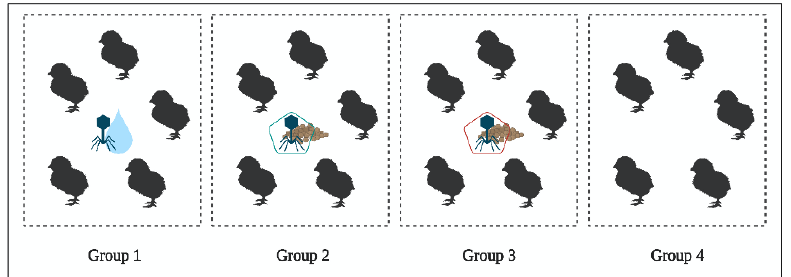
Figure 6. Experimental design of BP application in 1-day-old chicks. Group 1 received the FP via drinking water; group 2 received L100 via feed; group 3 received S100 via feed; and group 4 did not receive BP (control group). Created with BioRender.com .